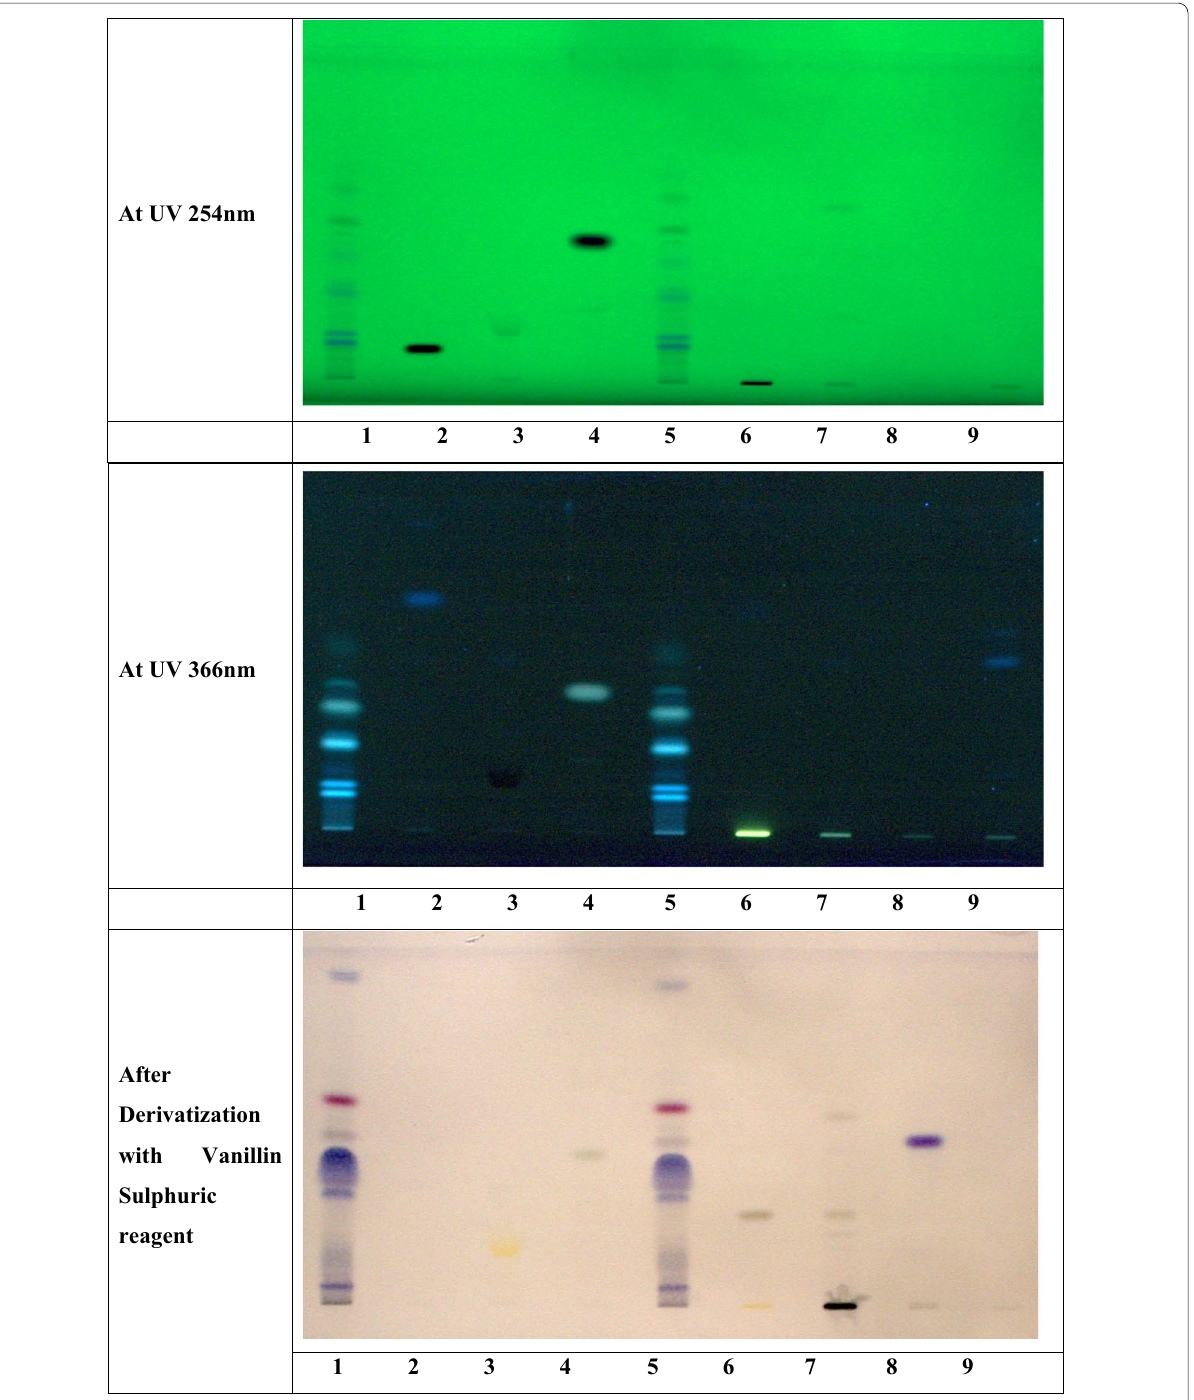
Fig. 1 HPTLC fingerprint profile of methanol extract of Anu Taila and various biomarkers compounds. T1 and T5: Anu Taila, T2: PHBA, T3: Embelin, T4: Marmelosin, T6: Berberine chloride, T7: Solasodine, T8: Lupeol, and T9: glycyrrhizin. Solvent system toluene/ethyl acetate/chloroform/methanol/ formic acid